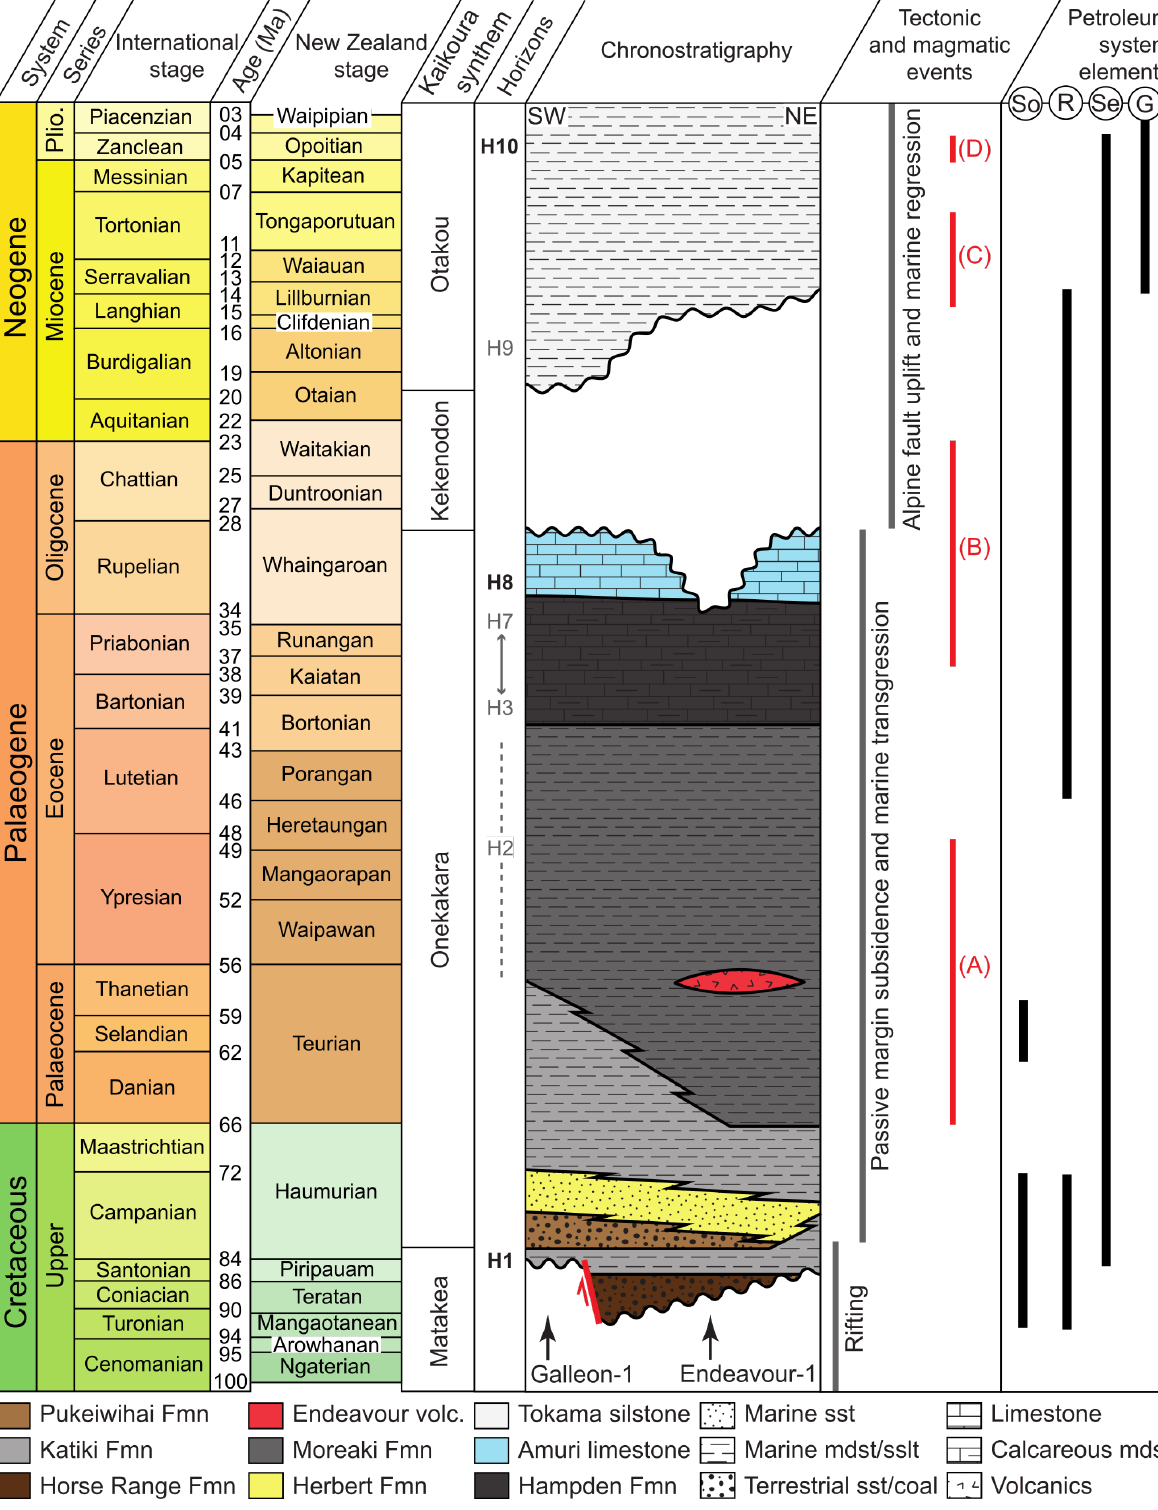
Figure 2: Tectono-stratigraphic framework of the Canterbury Basin highlighting ages of onshore magmatic events and phases of petroleum system development [after Carter 1988; Fulthorpe et al. 1996; Killops et al. 1997; Ben- nett et al. 2000; Timm et al. 2010; Uruski 2010]. Magmatic events correspond to: A = Geraldine and Timaru Lavas; B = Banks Peninsula; C = Cookson Volcanics; and D = View Hill, Central Canterbury [Timm et al. 2010]. Petroleum system elements correspond to: So = source rock; R = reservoir rock; Se = seal; and G = hydrocarbon